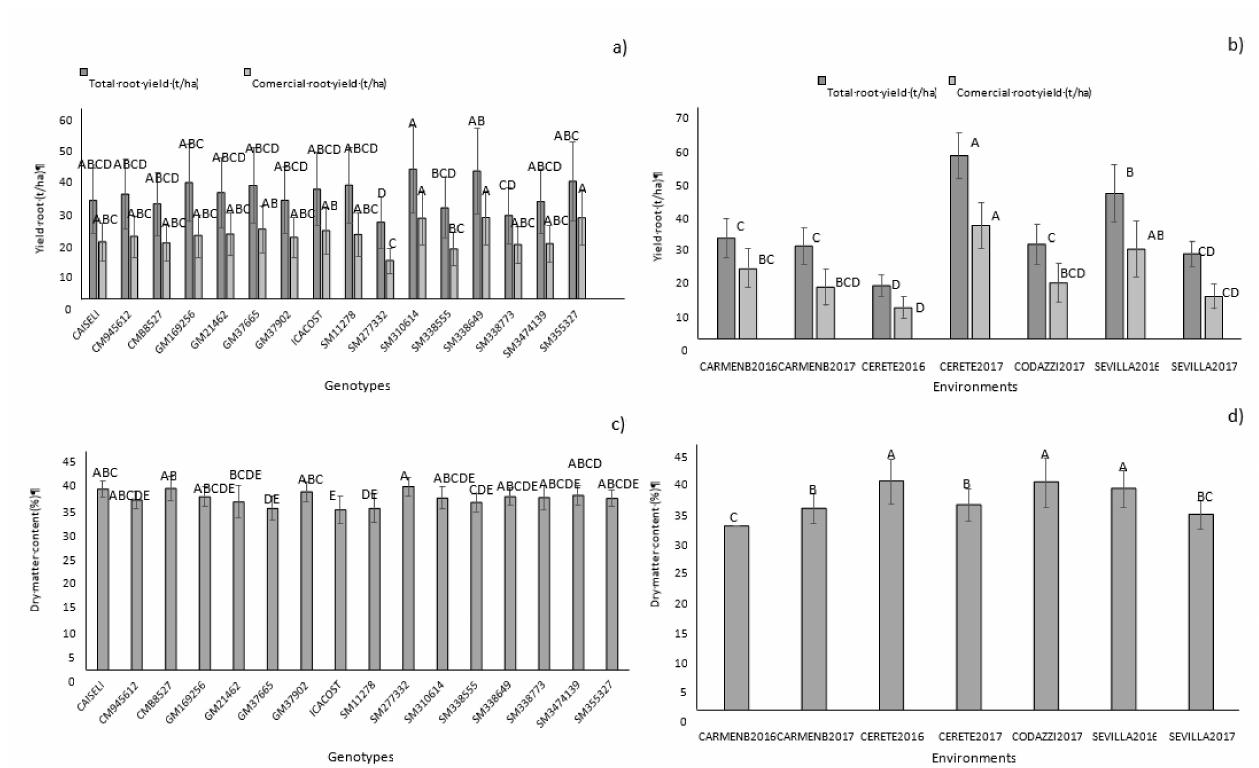
Figure 3. Agronomic performance of selected genotypes evaluated under several environmental conditions. ( a ) Total and commercial fresh root yield in evaluated genotypes. ( b ) Total and commercial fresh root yield in seven environments. ( c ) Dry matter content in evaluated genotypes. ( d ) Dry matter content of plants evaluated in seven environments. Different letters show significant differences obtained by Tukey’s test ( p <